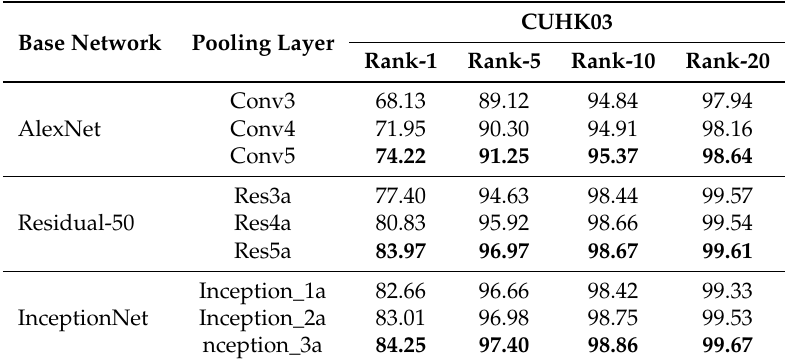
Table 9. Identification accuracy (%) of the proposed method with performing RoI pooling at different middle layers on CUHK03. The best result over various pooling layers is marked in bold.